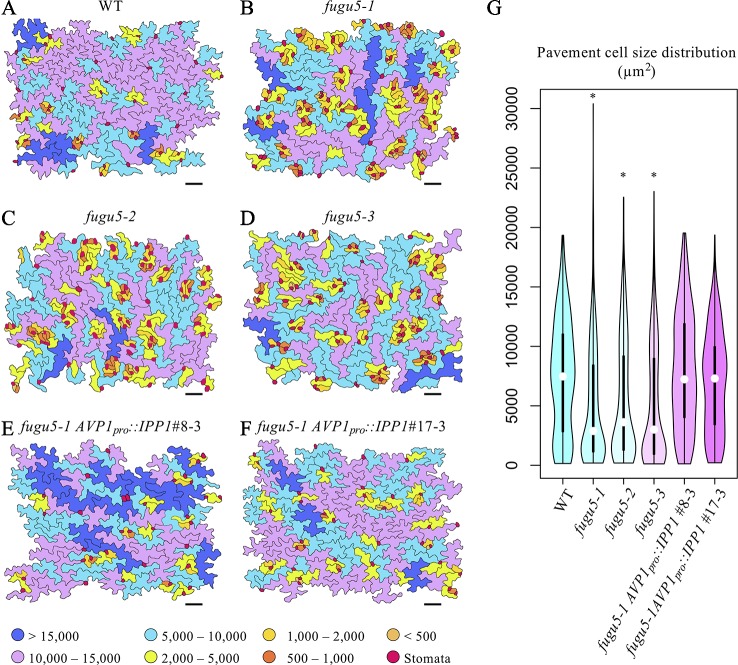
Distribution of pavement cell size. (A–F) SEM images of adaxial side pavement cells of the cotyledons of WT, fugu5-1, fugu5-2, fugu5-3, fugu5-1 AVP1pro::IPP1#8-3, and fugu5-1 AVP1pro::IPP1#17-3, respectively. Scale bar, 100 µm. Cells were traced and color-coded based on their size (µm2, see color scale chart). Note that the fugu5 mutants have a disturbed stomatal one-cell-spacing rule. (G) Violin plot showing pavement cell size distribution (n > 200 pavement cells from three cotyledons). Data are means ± SD. Asterisk represents a significant difference compared to the WT at P < 0.0001 (ANOVA with Tukey HSD test, KaleidaGraph ver. 4.1.4).